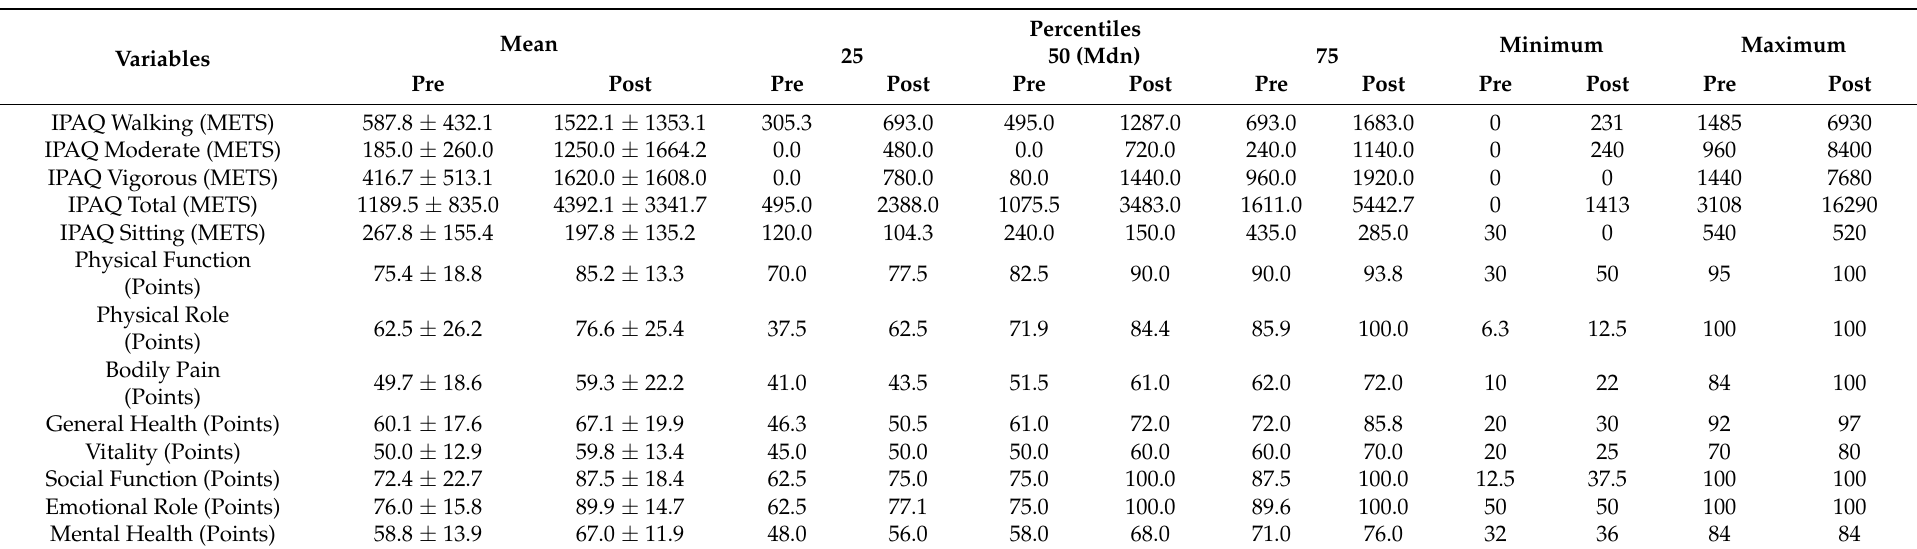
Table 2. Descriptive analysis of the variables pretest and